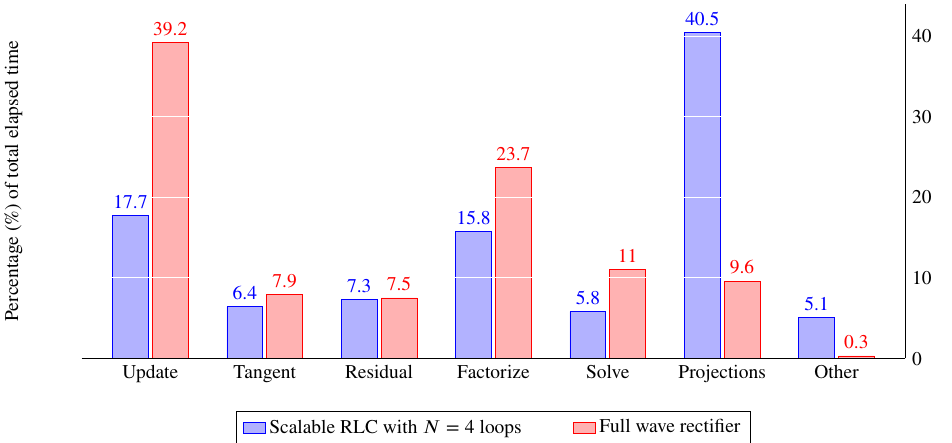
Figure 14. Percentage of total runtime elapsed by the TR method in each stage of the time-step.